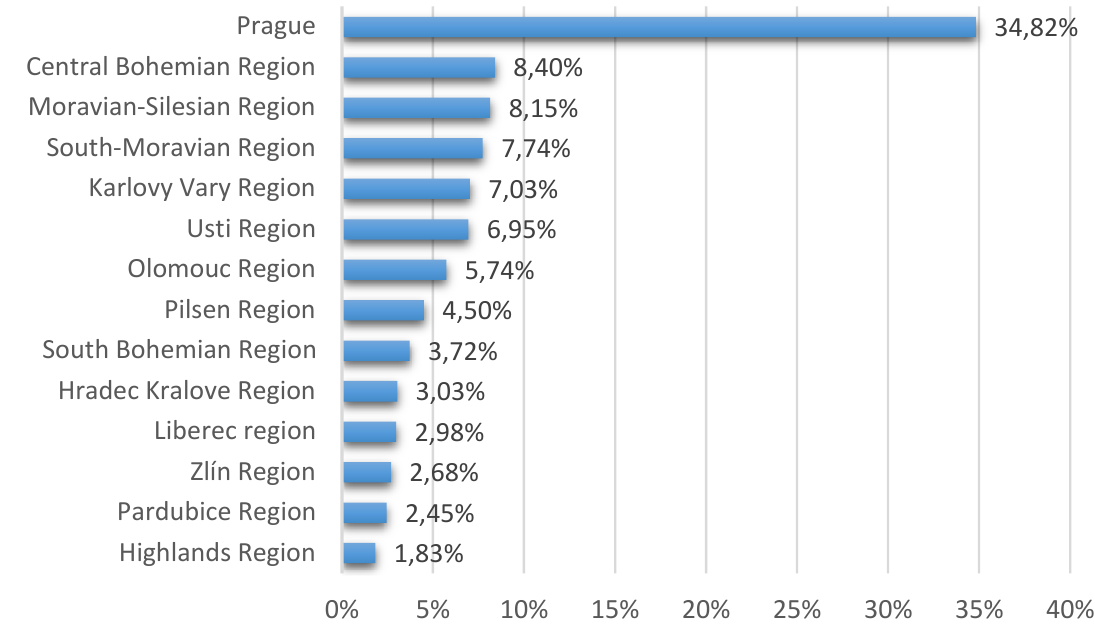
Figure 3: Percentage ratio of individual regions on the real estate market turnover in the Czech Republic in the category of apartments for sale, January 2018 to June 2021 Source: Software EVAL